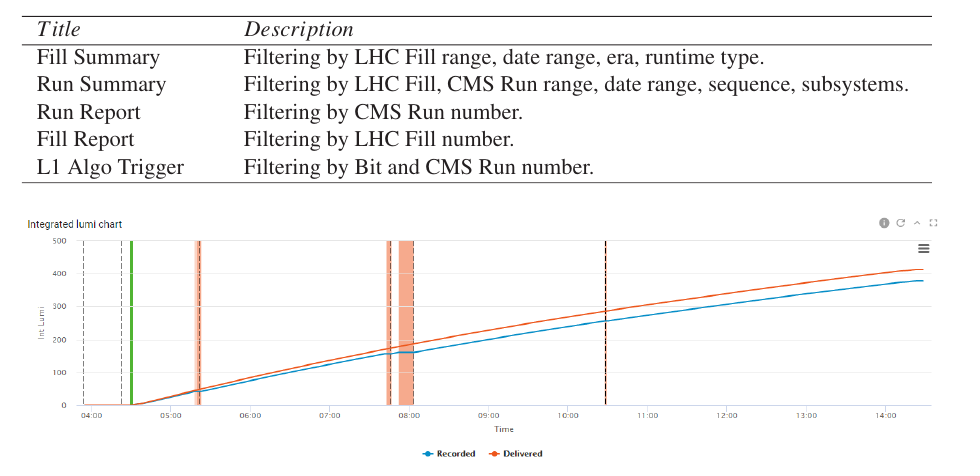
Figure 4. Integrated Luminosity Chart. First bar - start of LHC stable beam, sequent bars - downtimes, black dashed lines - start of new CMS